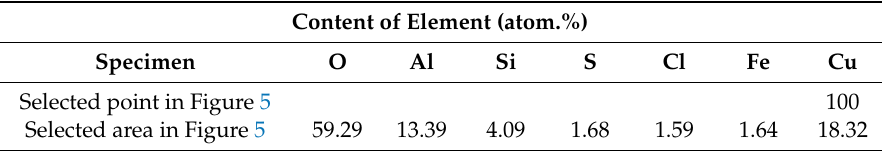
Table 3. The composition of the studied specimens by SEM with